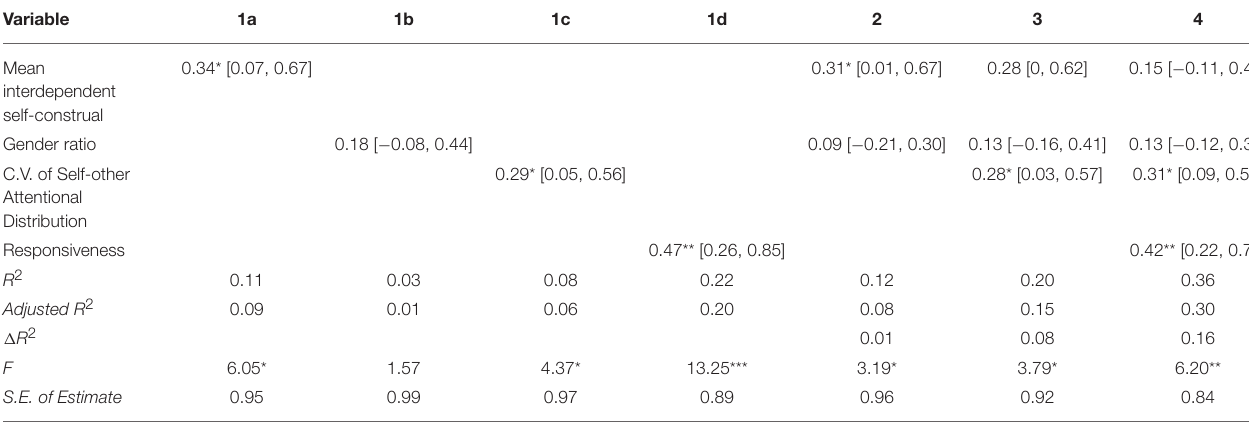
TABLE 3 | Summary of hierarchical regression analysis for variables predicting group-level team feeling ( n = 50 ). Variable